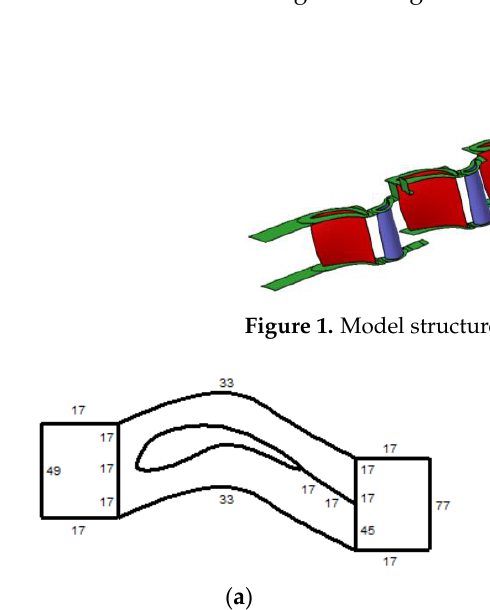
Figure 1. Model structure.